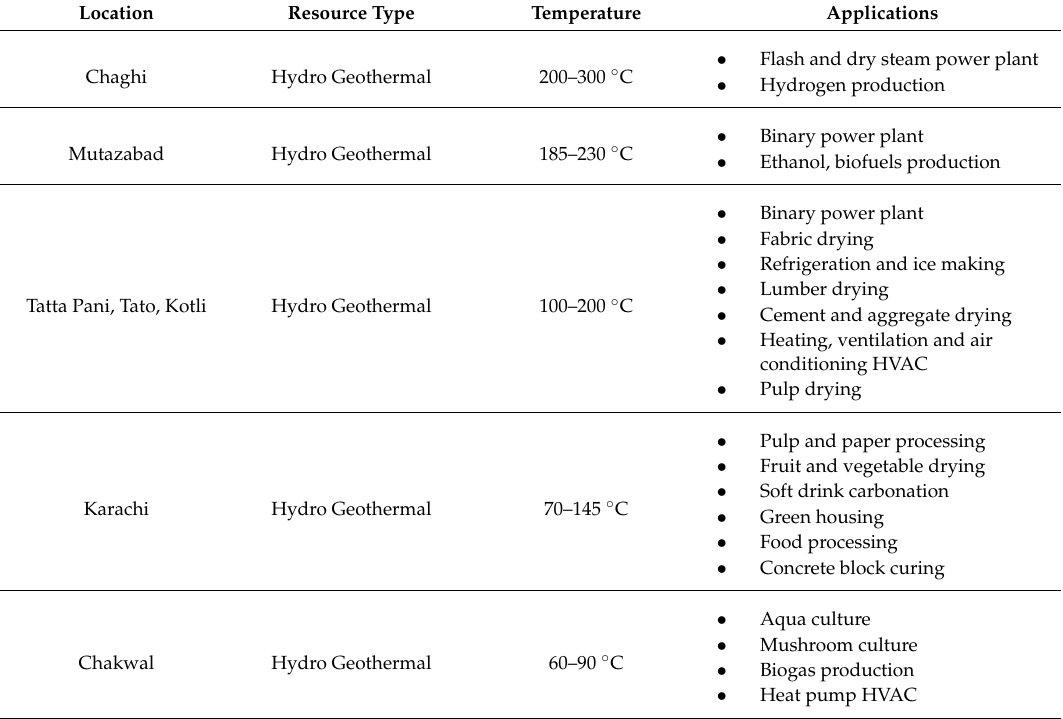
Figure 18. Map showing areas of geothermal activity and some important geological and tectonic features of Pakistan. (1.96”, 1.96). Table 13. Applications for the geothermal resources of Pakistan.